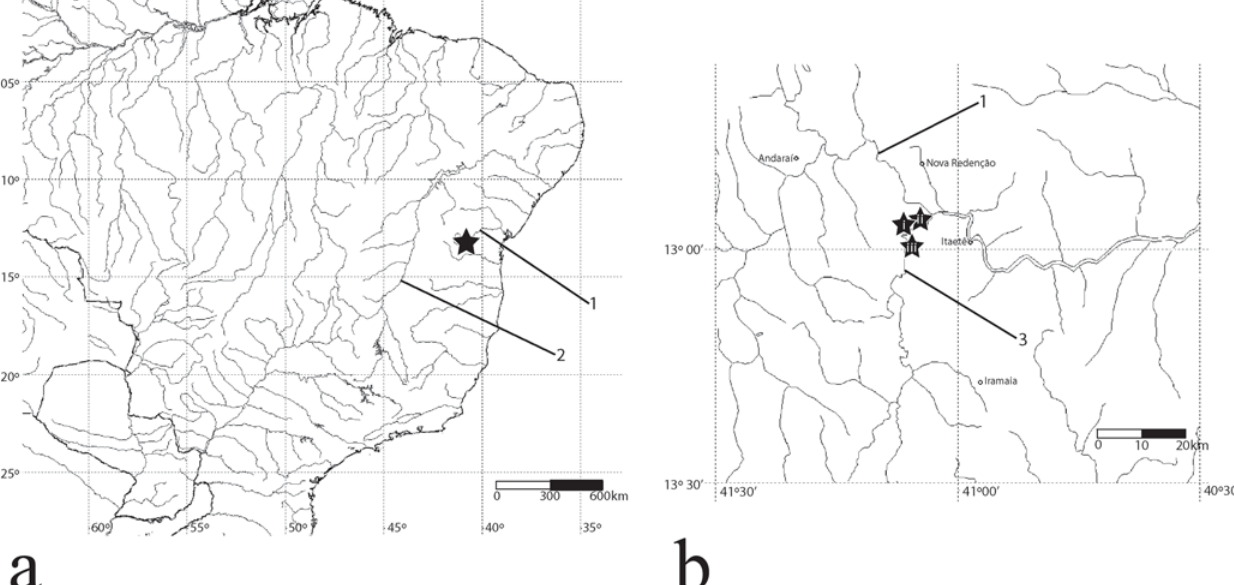
Fig. 14. Geographic distribution of Rhamdiopsis krugi . a ) Eastern Brazil; b ) detail of the upper rio Paraguaçu. Legends: 1 ) rio Paraguaçu; 2 ) rio São Francisco; 3 ) rio Una; i ) Poço Encantado; ii ) Lapa do Bode; and iii ) Gruta Natal. Symbol (star) in map a represents the three localities.